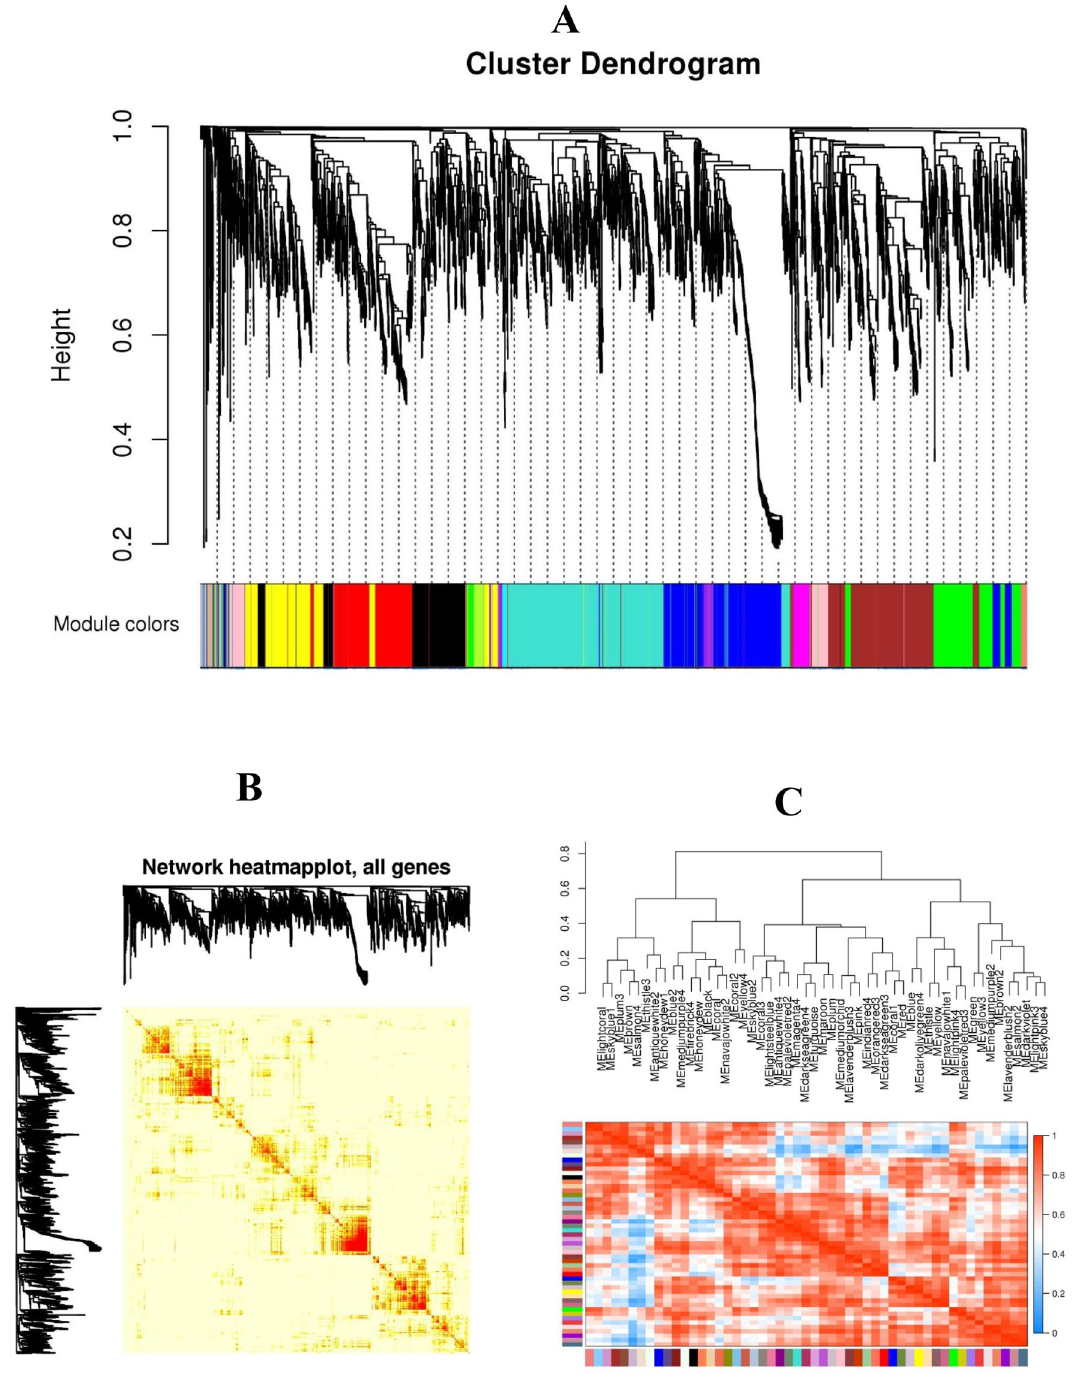
Figure 1. Weighted gene co-expression network analysis of salinity stress responses genes in D. salina . ( A ) Hierarchical cluster tree of the common genes between different studies. The branches and color bands represent the assigned module. The tips of the branches represent genes. ( B ) Heat map shows the Topological Overlap Matrix (TOM) value among the proteins of the network delimited in modules by the dynamic method . Low TOM is indicated by yellow color and higher TOM is indicated by progressively red color. ( C ) The module Eigen gene adjacency showed by hierarchical clustering and heat map. A module Eigen gene summarizes the gene expression profile of each module. Figures created by the WGCNA Bioconductor